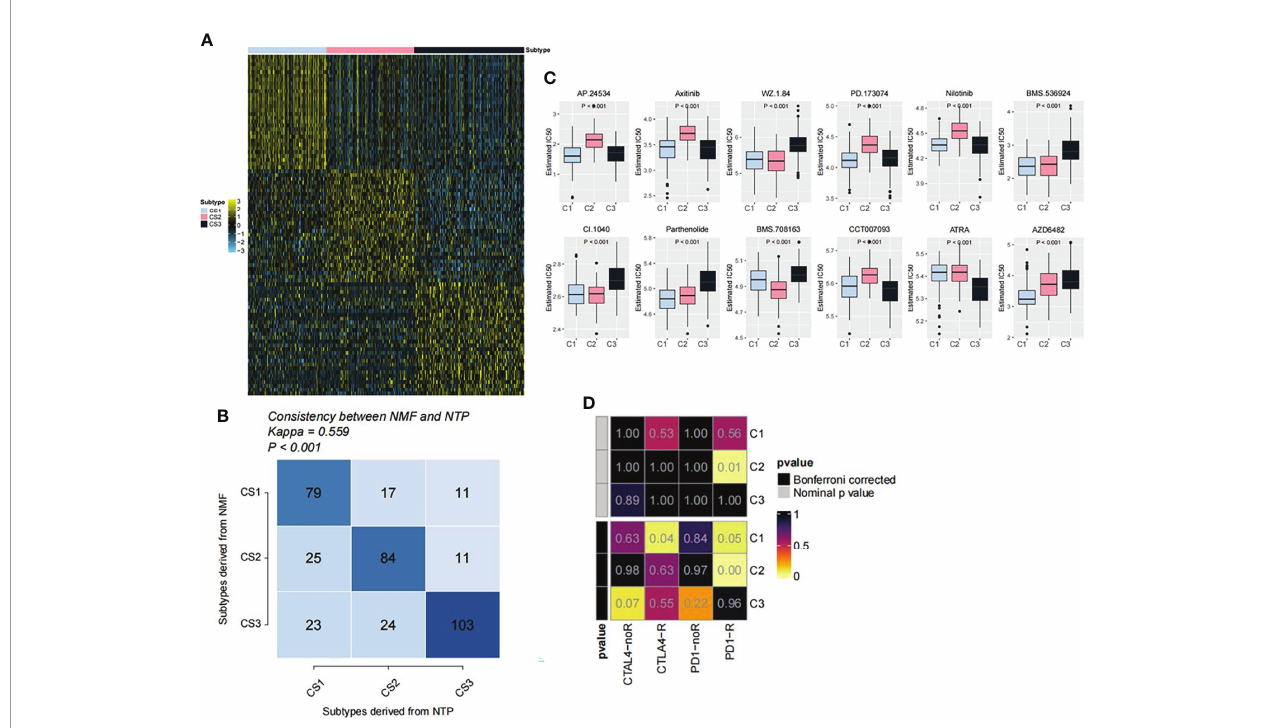
FIGURE 6 | Performance veri fi cation of immune classi fi ers. (A) Heatmap showing the classi fi cation of the 90-gene classi fi er for OV subtypes. (B) Correlation between NTP classi fi cation and NMF classi fi cation. (C) Drug sensitivity analysis of OV subtypes. (D) Prediction of the sensitivity of the three subtypes to anti-tumor